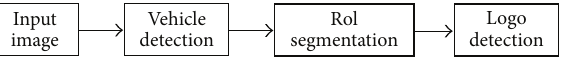
Figure 1: The overall logo detection process